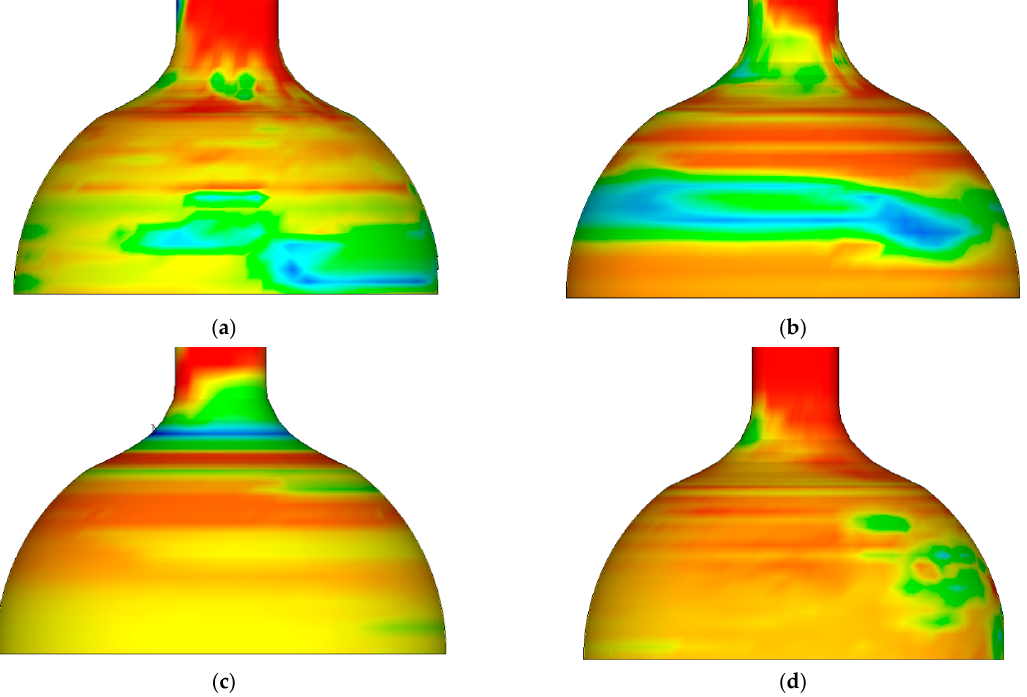
Figure 2. The cloud diagram of equivalent stress distribution after spinning at different tempera- tures . ( a ) Equivalent stress distribution map at 800 °C. ( b ) Equivalent stress distribution map at 900 ( a ) Equivalent stress distribution map at 800 ◦ C. ( b ) Equivalent stress distribution map at 900 ◦ C. °C. ( c ) Equivalent stress distribution map at 1000 °C. ( d ) Equivalent stress distribution map at 1100 °C. ( c ) Equivalent stress distribution map at 1000 ◦ C. ( d ) Equivalent stress distribution map at 1100 ◦